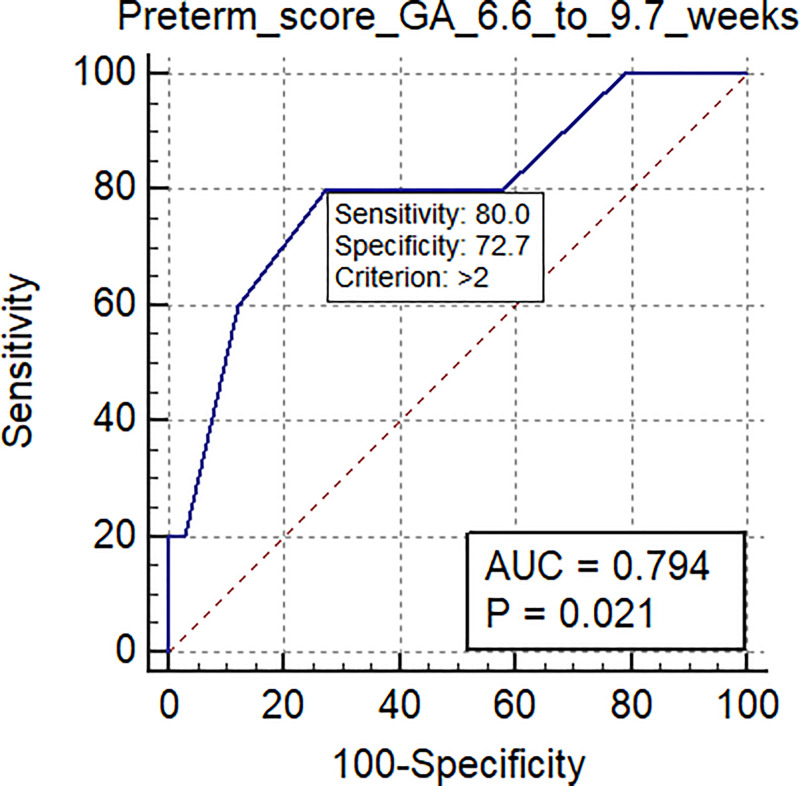
The AUC-ROC score for spontaneous preterm birth in the early first trimester time range (6.6–9.7 weeks gestational age; mean 8.4 ±1.0 weeks) was 0.79 (95% CI: 0.63 to 0.91; p = 0.02) in the validation set.